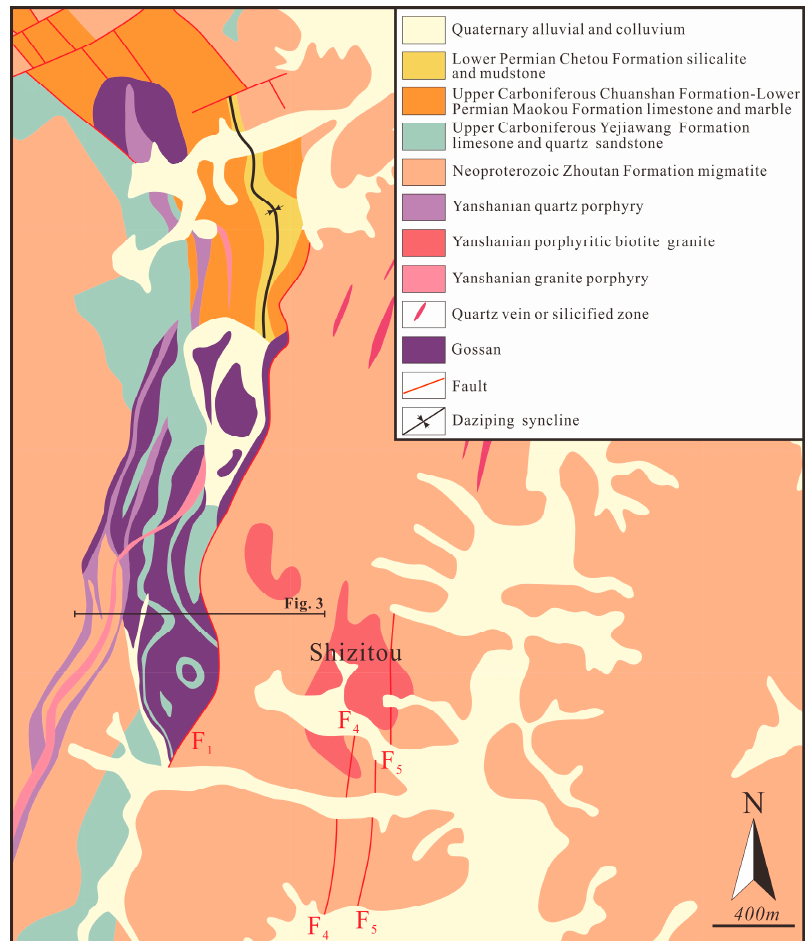
Figure 2. Geological map of the Yongping Cu deposit (modified after [60]).